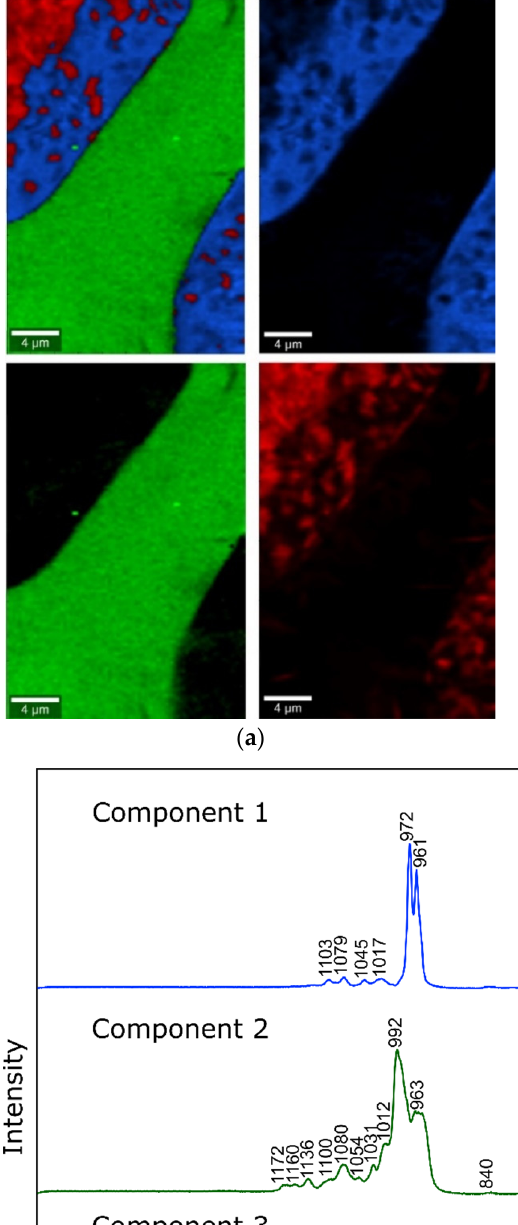
Figure 9. Raman measurements of sample 2B_1007. ( a ) Raman images obtained from the cluster analysis and ( b ) average Raman spectra from corresponding clusters: Component 1— CaMgSi 2 O 6 -diopside type, Component 4—glass matrix.